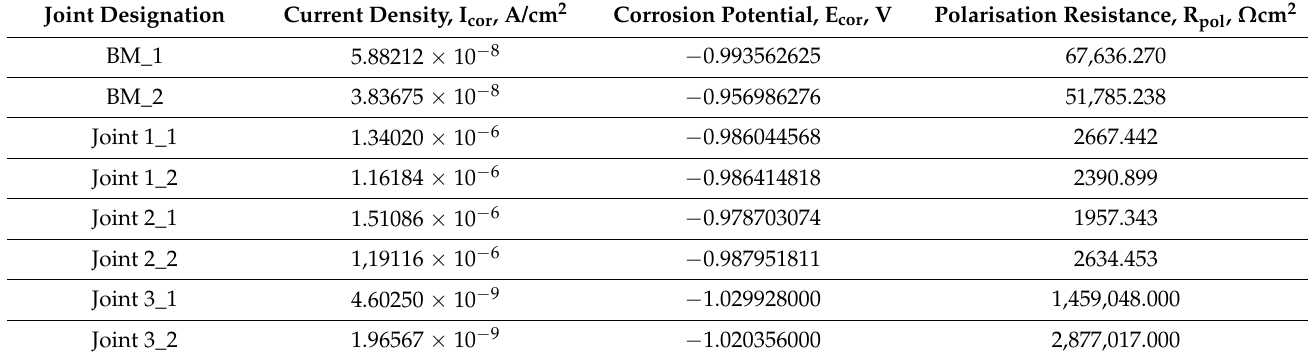
Table 5. Corrosion potential measurement